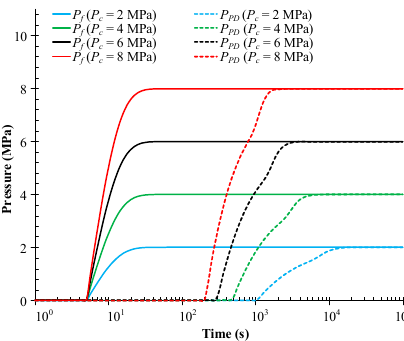
Figure 14. Evolution of fracture pressure and pore pressure at Point D for different injection pressure increments. P f denotes the fracture pressure and P PD denotes the pore pressure at Point D .